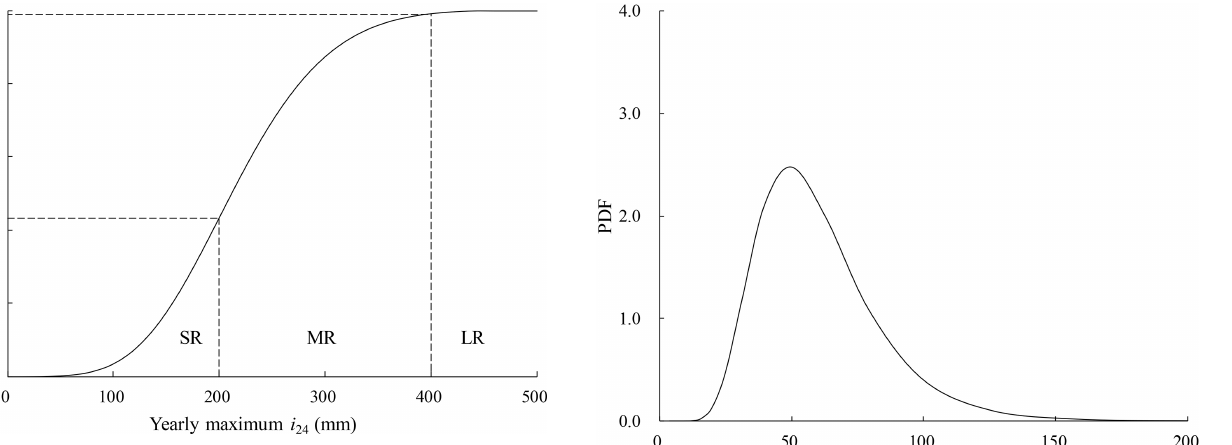
Figure 6. CDF of the yearly maximum i 24 in Hong Kong.